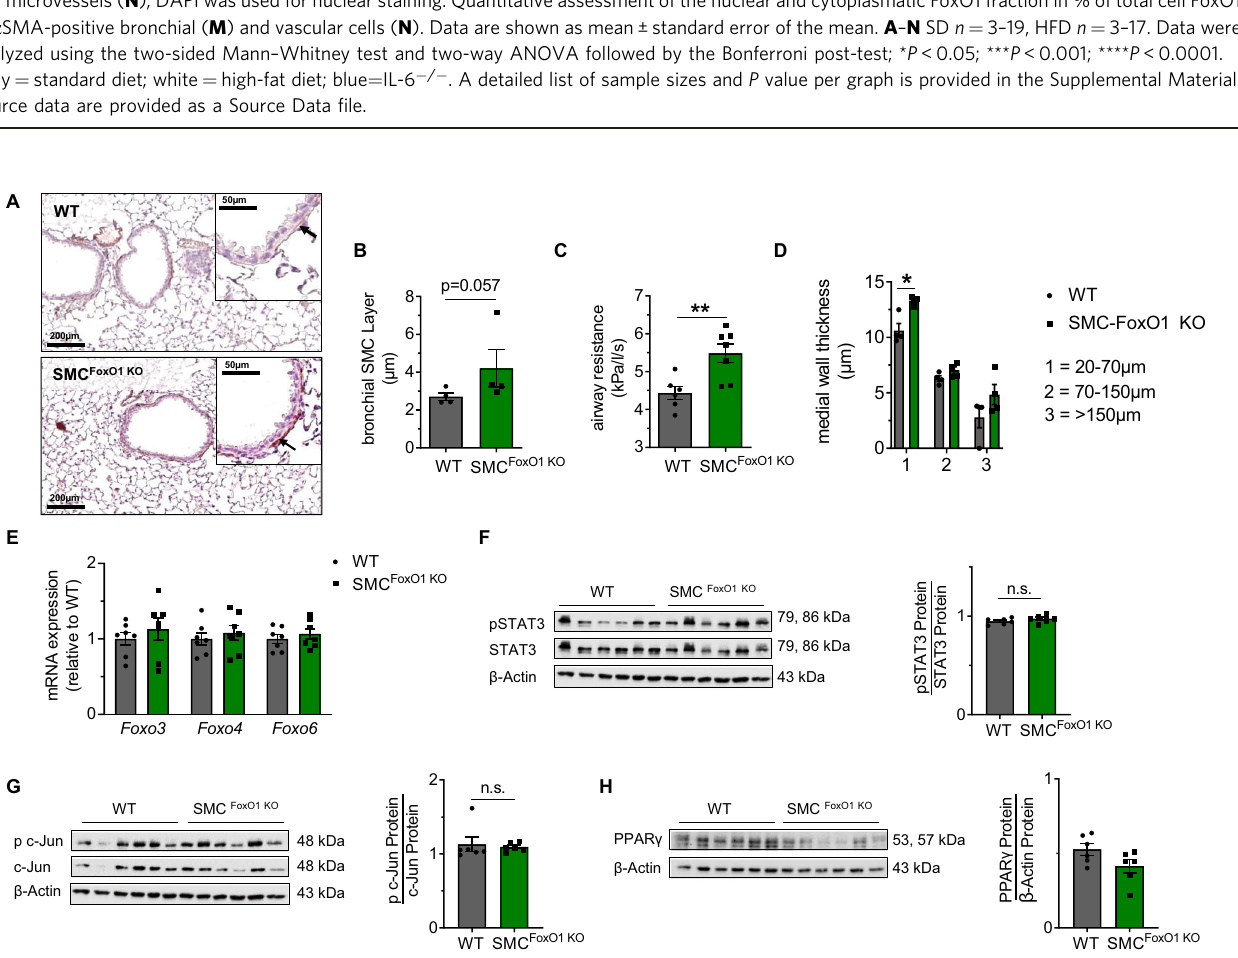
Fig. 7 Offspring of Interleukin (IL) − 6-de fi cient dams fed a perinatal high-fat diet (HFD) are protected from structural and functional lung changes at postnatal day 70 (P70) despite early-onset obesity and impaired glucose tolerance. A Body weight and ratio of white adipose tissue (WAT) relative to body weight of the offspring of HFD- and standard diet (SD)-fed dams at P21 and P70. B Serum insulin and leptin concentrations at P21 using ELISA. C Offspring of HFD- and SD-fed dams were subjected to an intraperitoneal glucose tolerance test (ipGTT) at P21. D – F Representative images of lungs from offspring at P70. Tissues were stained for α -smooth muscle actin ( α SMA) to assess the bronchial SMC layer ( D ). Quantitative measurement of the bronchial SMC (bSMC) layer in bronchi with a diameter of <150 µ m and 150 – 200 µ m ( E ). Assessment of respiratory airway resistance using body plethysmography at P70 ( F ). G – I Representative images of lungs from offspring at P70. Tissues were co-stained for α SMA and von Willebrand factor using qRT-PCR. K , L Representative immuno fl uorescent images of lungs from offspring at P21. Tissues were stained for α SMA and Ki67. The Ki67-positive